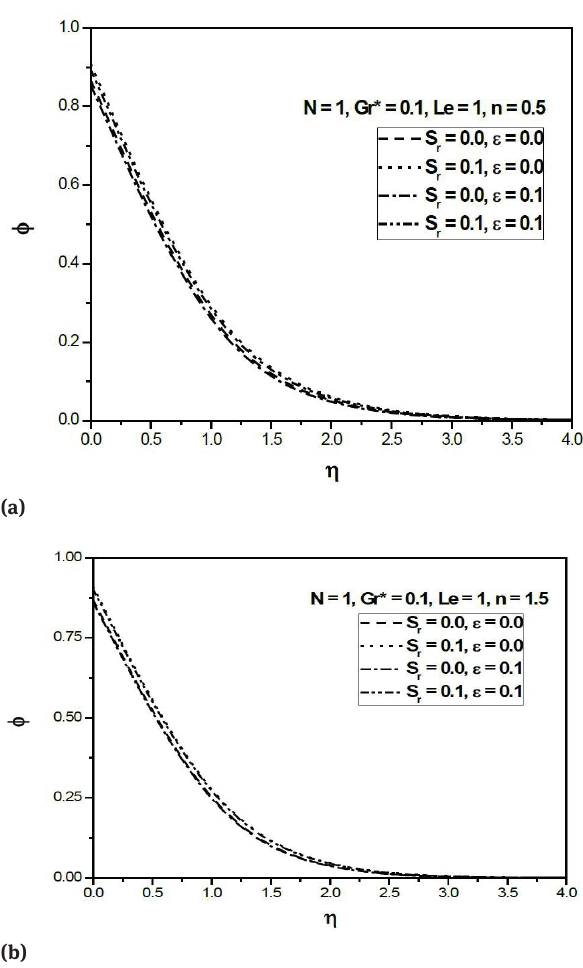
Fig. 3: (a) Variation of concentration profiles against η for n = 0.5 (Aiding Buoyancy); (b) Variation of concentration profiles against η for n = 1.5 (Aiding Buoyancy)